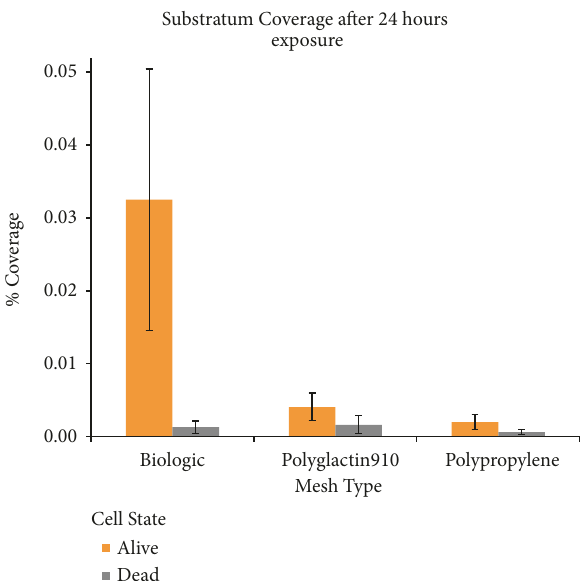
Figure 3: Substratum Coverage after 24 hr Exposure to MRSA. Quantification of biofilm substratum coverage, orange bars represent viable bacteria and light grey bars nonviable